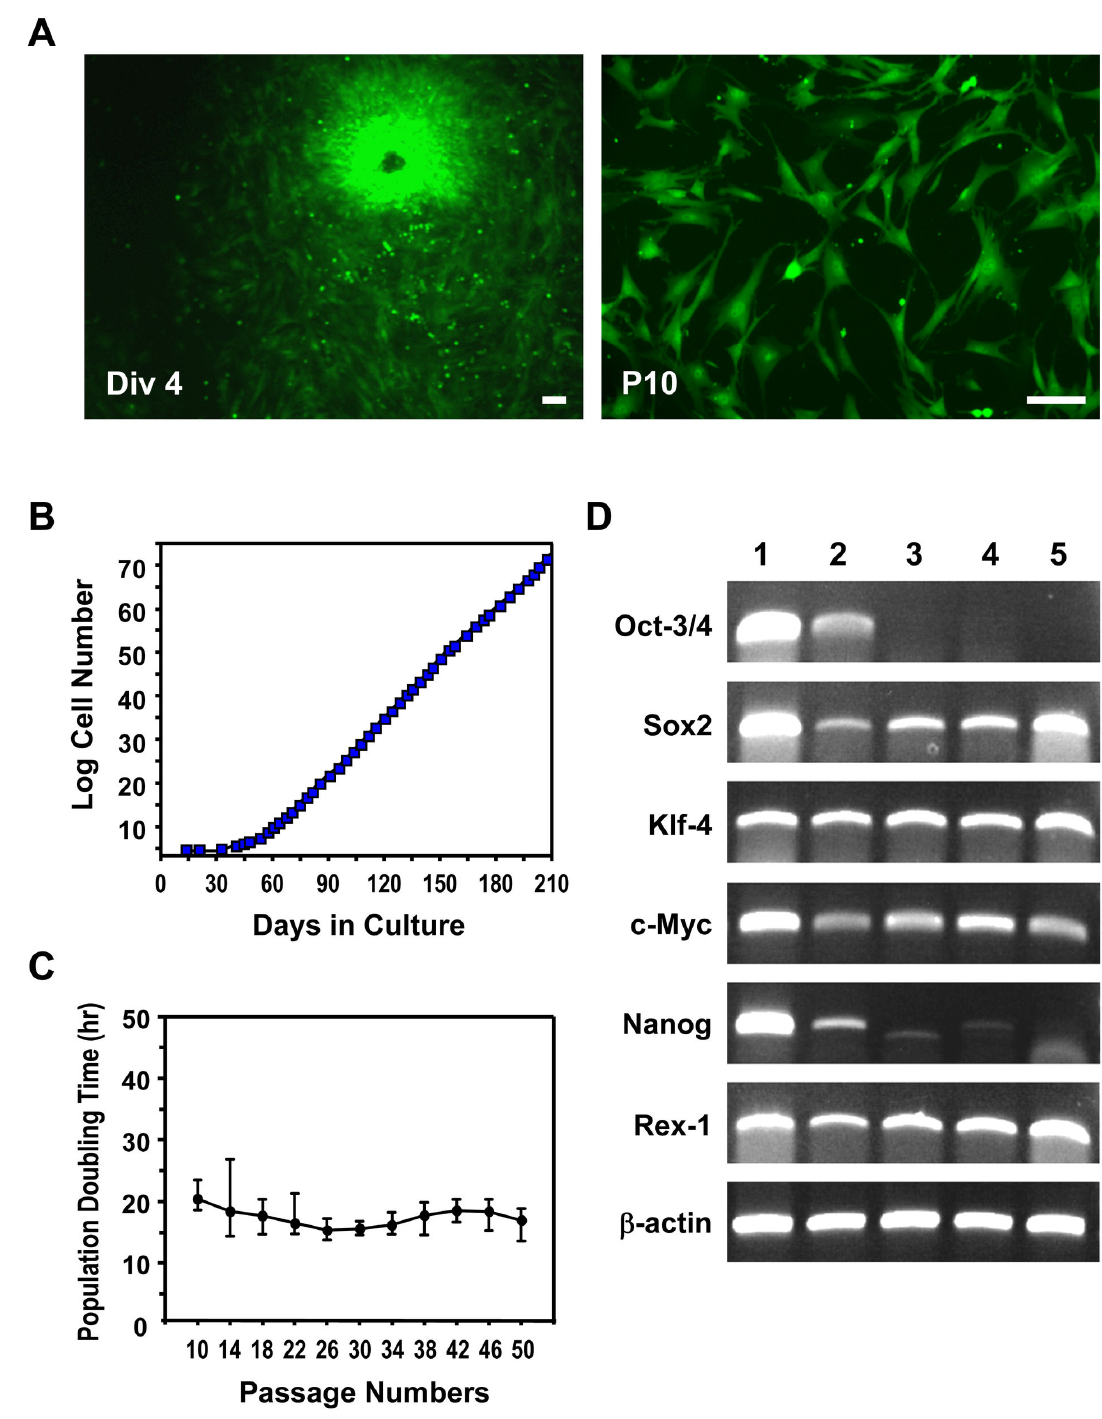
Figure 1. Isolation of novel MSCs from mouse umbilical cord. (A) Mouse UC-MSCs isolated from GFP transgenic mice at passage numbers 0 (Div 4) and 10 (P10). mUC-MSCs displayed the triangular, spindle-shaped, and fibroblast-like morphology at P10. (B) Growth Kinetics of mUC-MSCs. Cumulative cell number was counted at each passage. (C) The population doubling time pattern of mUC-MSCs from passage 10 to passage 50. (D) RT-PCR analysis of the pluripotency-associated genes in mUC-MSCs. Lane 1, mES cells; lane 2, germ cells from testis; lane 3, mUC-MSCs from heterogeneous populations (Mix); land 4-5, mUC-MSCs derived from different single colony. Scale bar = 50 µm. doi: 10.1371/journal.pone.0074478.g001 PLOS ONE |